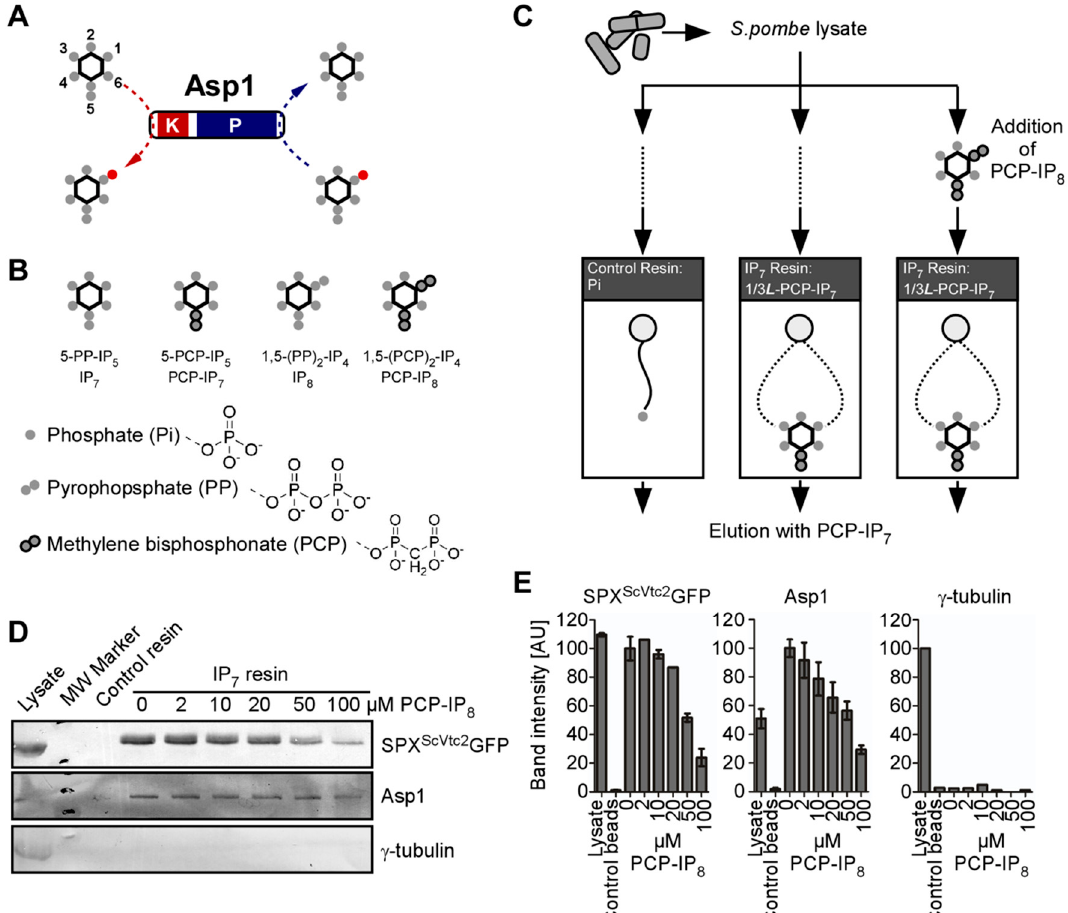
Figure 1. Endogenous Asp1 targets IPPs. ( A ) Schematic representation of the catalytic activities of S. pombe Asp1; K, kinase domain; P, pyrophosphatase domain. The myo -inositol ring is represented by a hexagon and the position of the phosphates (filled gray circles) on the inositol ring are numbered. The 1- β -phosphate (position C1), which is added and removed by Asp1, is colored red. ( B ) Graphical depiction of IP 7 and IP 8 and their corresponding metabolically-stable analogues. ( C ) Experimental overview of the affinity enrichment strategy and reagents that were utilized for the analysis of S. pombe cell lysates. The lysate was aliquoted and a subset of these aliquots was spiked with different concentrations of PCP-IP 8 prior to incubation with control or IP 7 resin. The linker that was utilized for the immobilization of Pi is depicted as a solid line. PCP-IP 7 is immobilized on beads through a linker that is attached to the phosphate at either position C1 or C3 of the inositol ring (1/3 L -PCP-IP 7 ). All of the samples were eluted with PCP-IP 7 . ( D ) Western blot analysis of lysate and eluates from control and IP 7 resin. The final concentration of PCP-IP 8 that was used for each sample is noted. Endogenous proteins were detected with antibodies against Asp1 or γ -tubulin. A GFP antibody was used to detect SPX ScVtc2 GFP. 1 technical replicate shown. ( E ) Band intensity quantification of proteins that were analyzed by Western blots in (D). Asp1 = 3; SPX ScVtc2 GFP = 2; γ -tubulin = 1 technical replicate. Arbitrary units (AU).